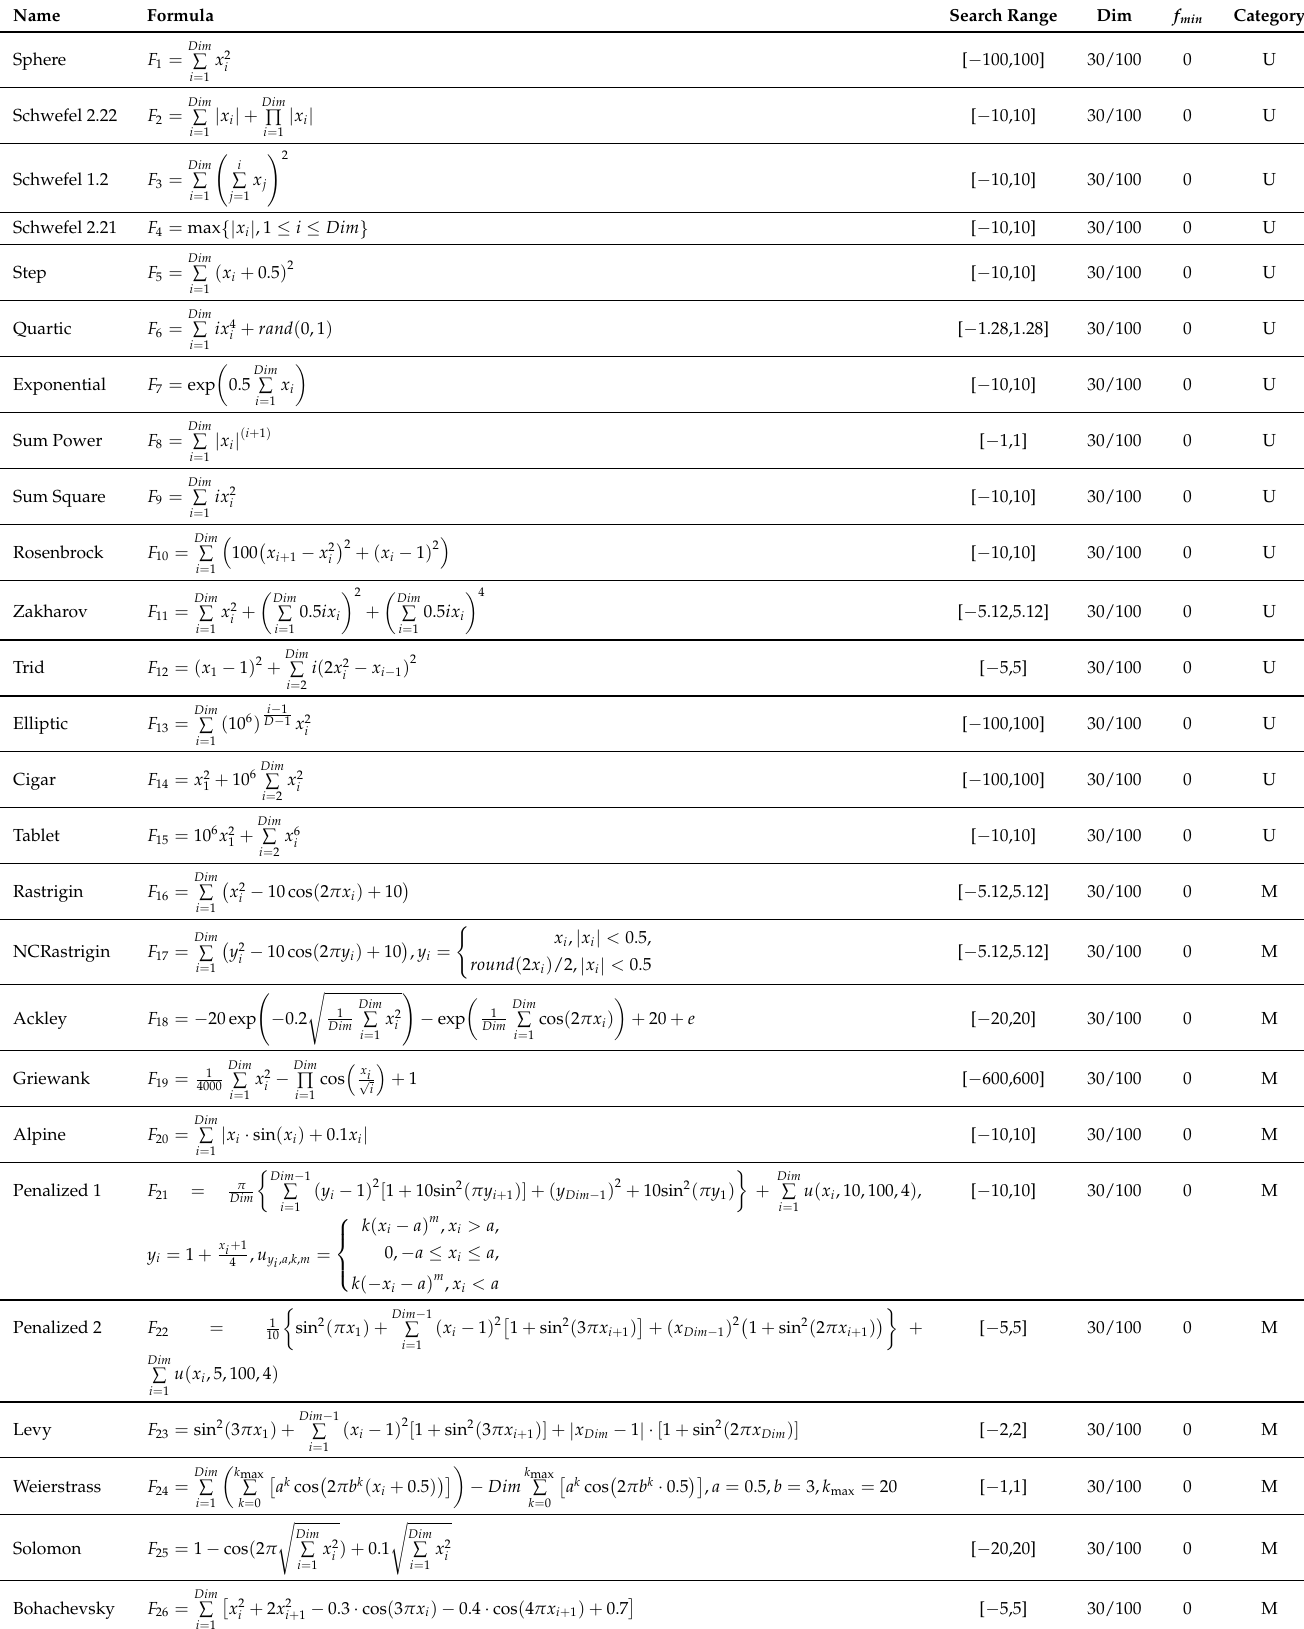
Table 2. Twenty-six benchmark